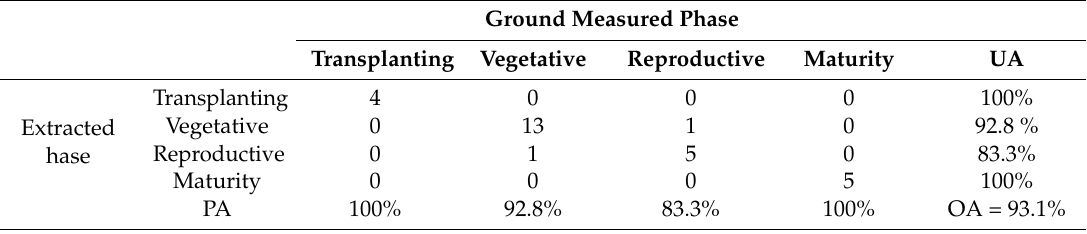
Table 5. Confusion table derived by validation data for the phenology retrieval algorithm using entropy, anisotropy, and dominant alpha. UA stands for user's accuracy, PA producer's accuracy, and OA overall accuracy. Kappa denotes kappa coefficient.